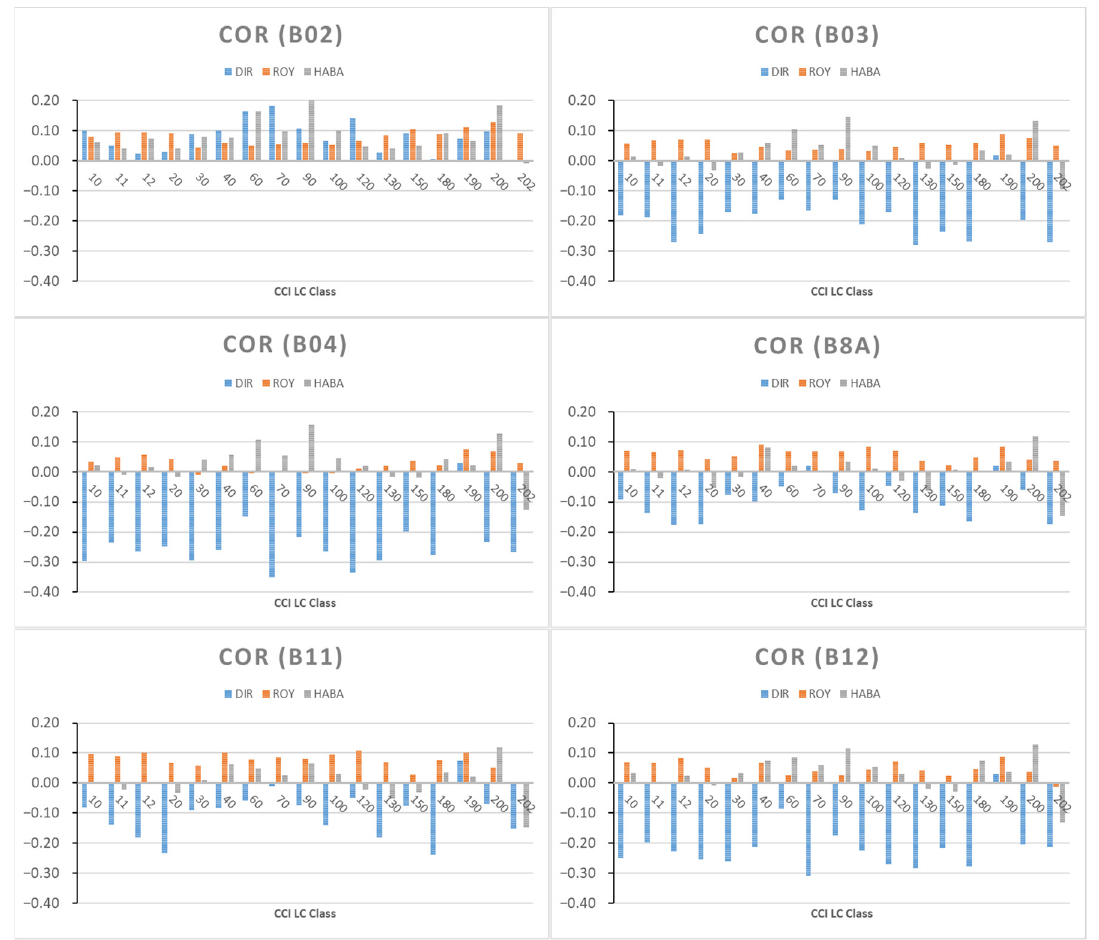
Figure 12. TSI Correlation metric results for S2L bands and for each CCI LC class (31TF, year 2019J).